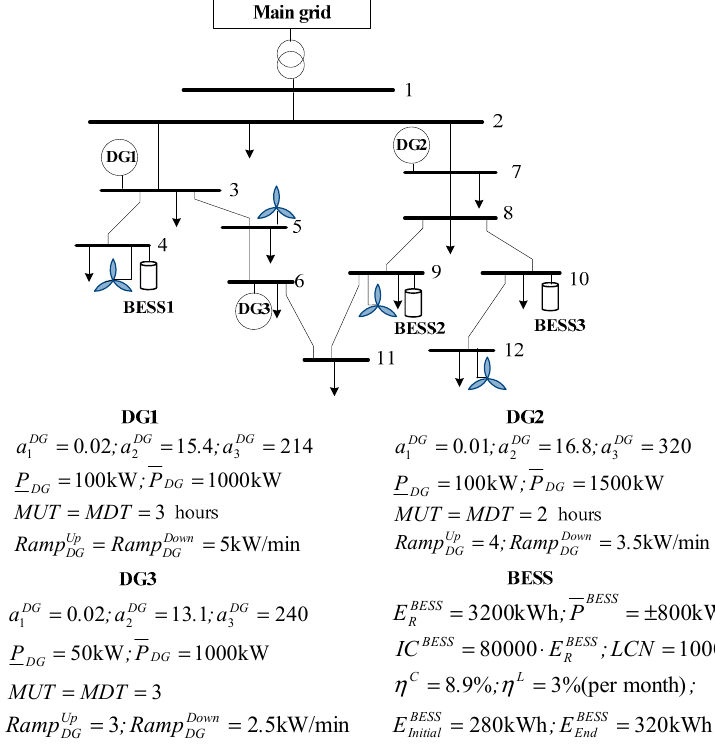
Figure 3. One-line diagram of the 12-bus VPP system.